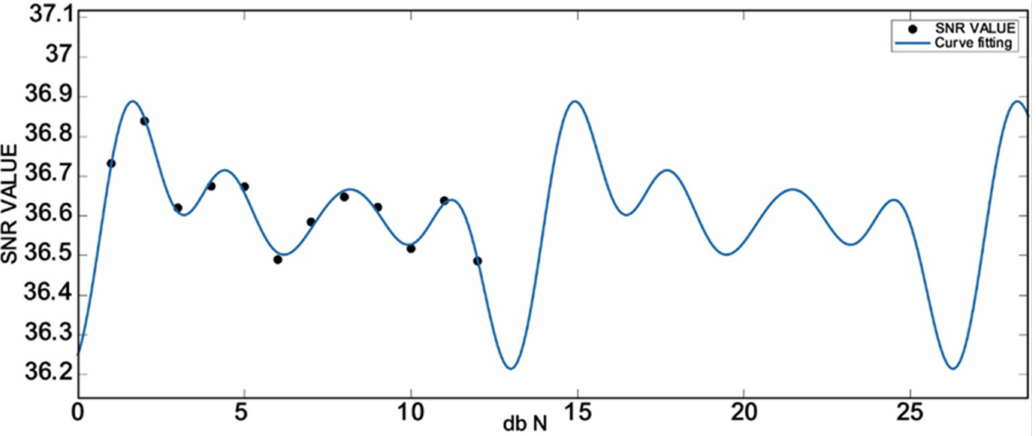
Figure 8. The SNR fitting curve of the db wavelet packet